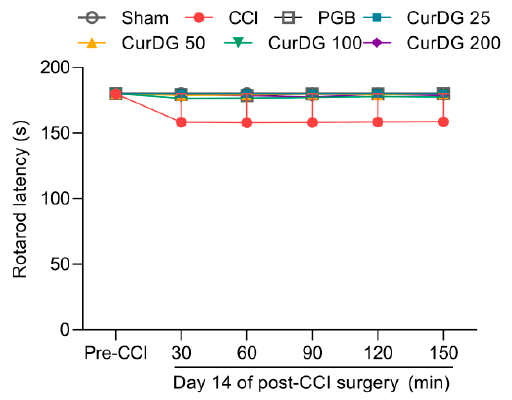
Figure 4. E ff ect of vehicle, pregabalin (PGB), and CurDG on the motor coordination in CCI-mice (Data are shown as mean ± SEM; n = 8 mice per